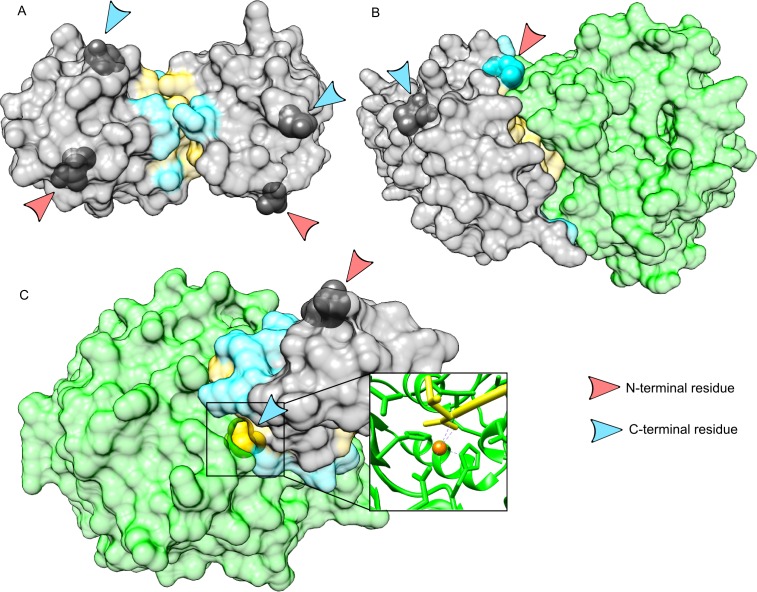
Examples of terminal residue implication at protein-protein interfaces.A: complex between the caspase-recruitment domain of APAF-1 (Apoptotic Protease Activating Factor 1) and the pro-domain of human procaspase-9 (PDB code 3YGS [27]). In this complex, all the terminal residues are genuine, and none of them is involved at the protein-protein interface. B: complex between two subunits of the mRNA capping enzyme of the vaccinia virus (PDB code 2VDW [28]). The genuine N-terminal residue of the small subunit is involved in the rim of the interface. C: complex between a human carboxypeptidase and an inhibitor from leech (PDB code 1DTD [29]). In this complex, the C-terminal residue of the inhibitor is buried at the core of the interface. The close-up view reveals that the terminal carboxylate group of the backbone is interacting with a Zinc ion, which is also coordinated by three side-chains of the enzyme. Interfaces are colored in yellow (core) and cyan (rim). Terminal residues are represented as opaque spheres and highlighted by arrows. Images are generated using UCSF Chimera [30].